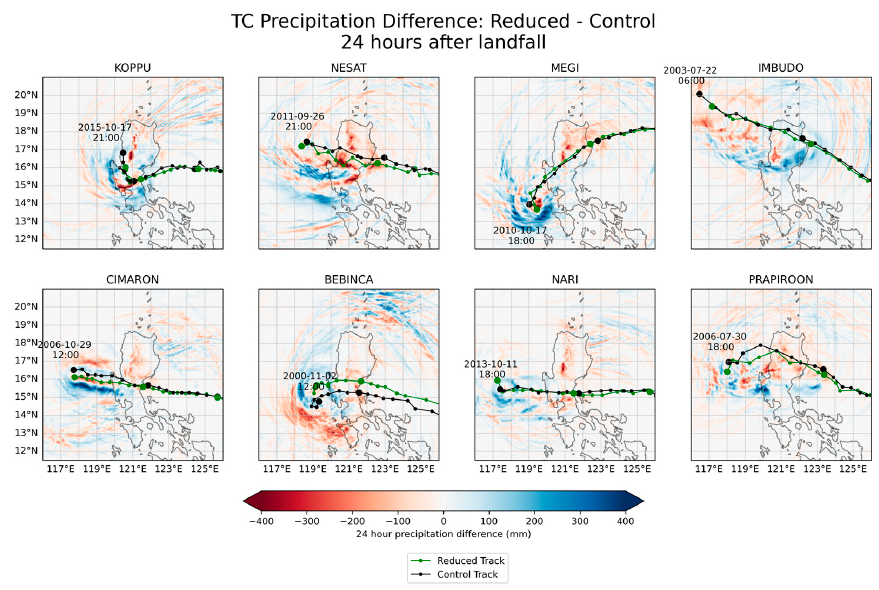
Figure 8. Similar to Figure 7, but for the difference in 24 h accumulated precipitation after landfall between Reduced and Control.